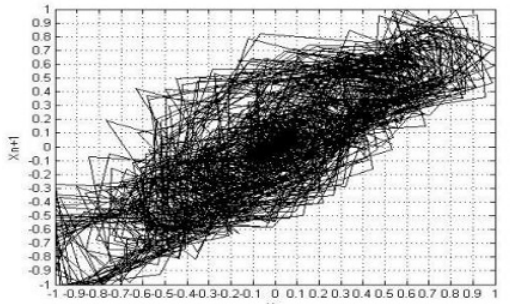
Figure 2. RPS model for the vowel ‘a’ sound